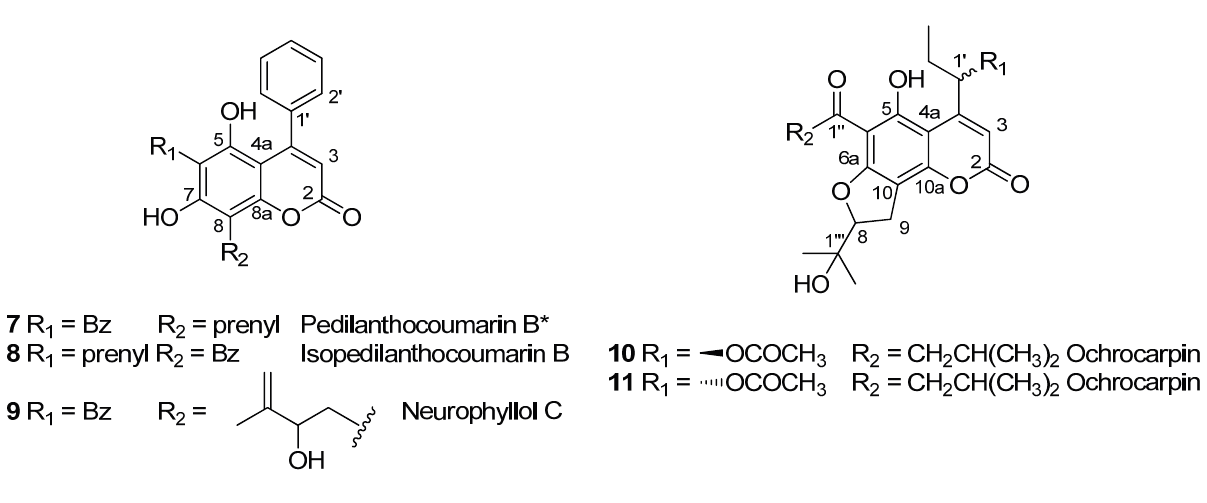
Figure 2. Structure of new or revised coumarins 7 to 11 isolated from Mammea neurophylla bark. * Revised structure of pedilanthocoumarin